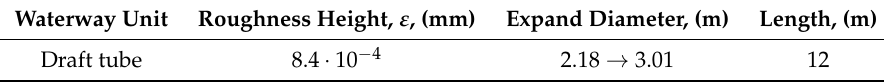
Table 5. The draft tube pipe parameters tuned with the least squares error